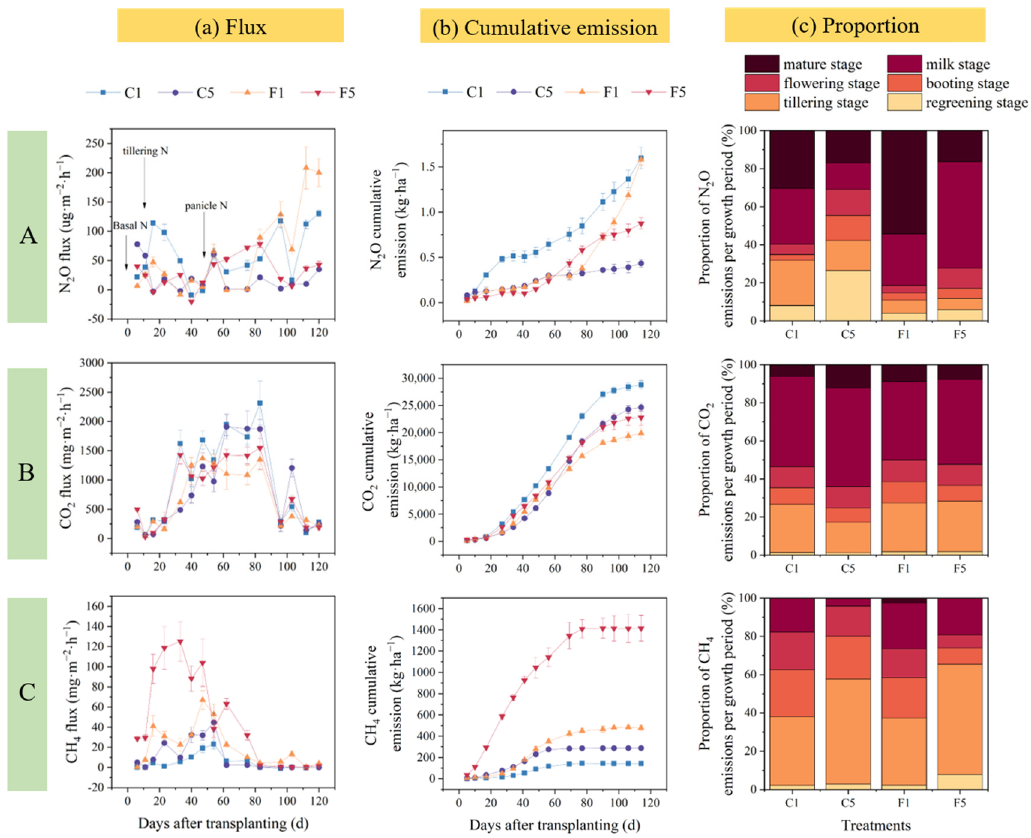
Figure 3. Fluxes, cumulative emissions, and emission percentages in each growth period of N 2 O, CO 2, and CH 4 . Column ( a ) shows the flux changes in the three GHGs. Column ( b ) shows the cumulative emissions changes for the three GHGs. Column ( c ) shows the percentages of the three GHG emissions in each growth period of rice. Row A, from left to right, represents the N 2 O flux change, the cumulative emission change, and the emission percentage of rice in each growth period. Row B from left to right represents the change in CO 2 flux, the change in cumulative emission, and the emission percentage of rice in each growth period. Row C from left to right represents the CH 4 flux change, the cumulative emission change, and the emission percentage of rice in each growth period. The black arrow indicates the application of N fertilizer. C1: controlled irrigation with 1-year straw